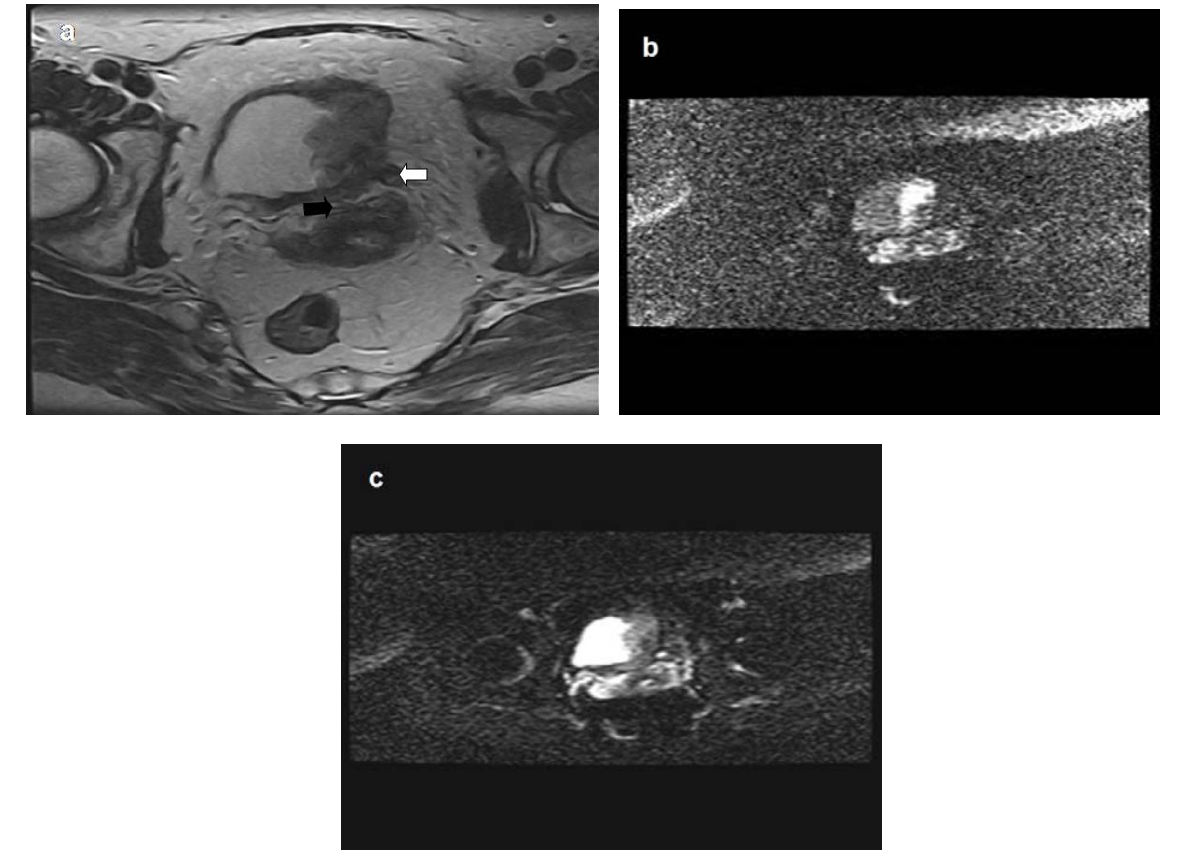
FIGURE 2. (a) Axial high-resolution T 2 -weighted MRI of urinary bladder showing a tumor growth at the left lateral wall infiltrating the left ureter (white arrow) and the corpus uteri (black arrow). (b) DW MRI showing the mass of hyperintense SI with no extravesical extension. (c) ADC map showing the mass with low SI.